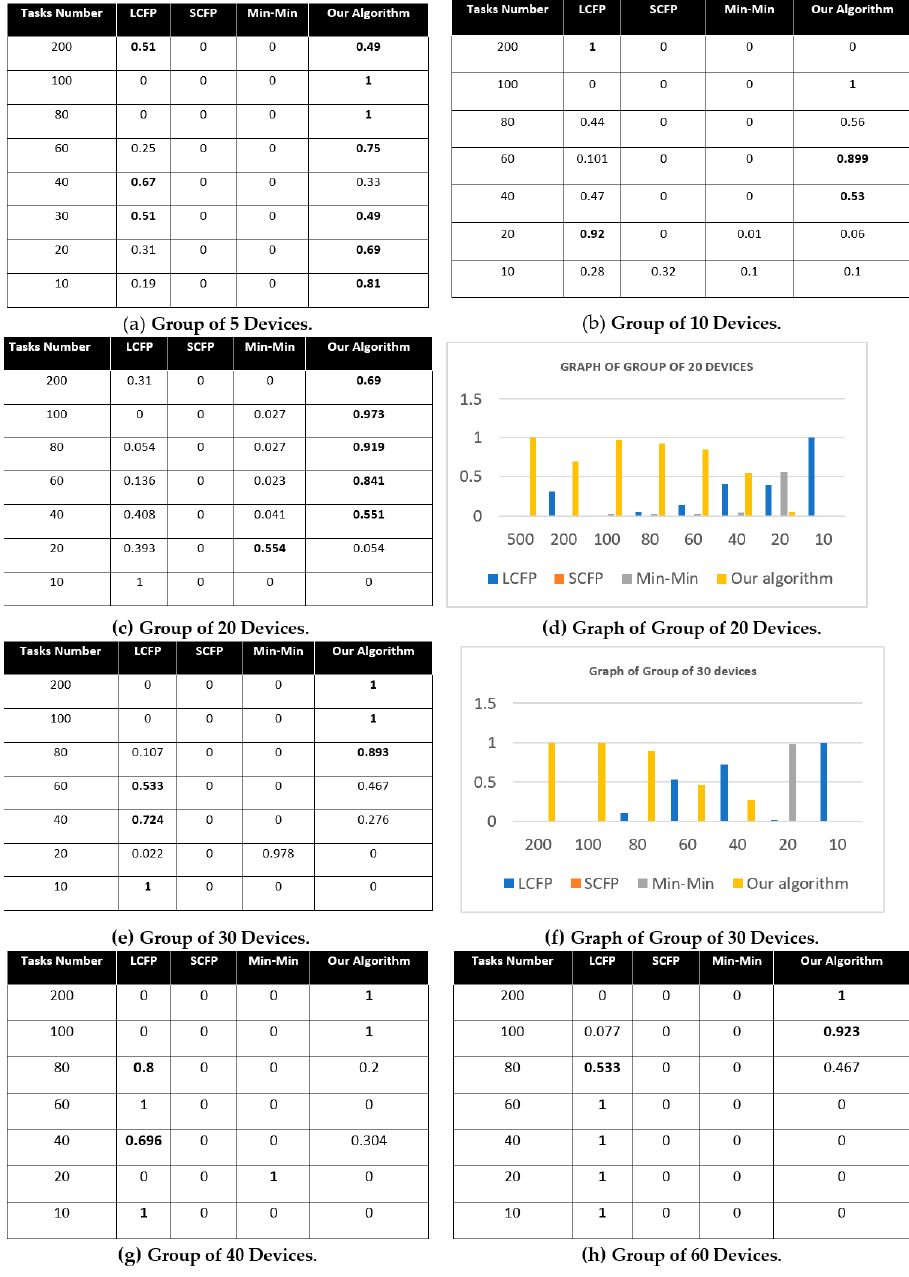
Figure 5. Performance of the algorithms with regard to the quality of the generated solutions.